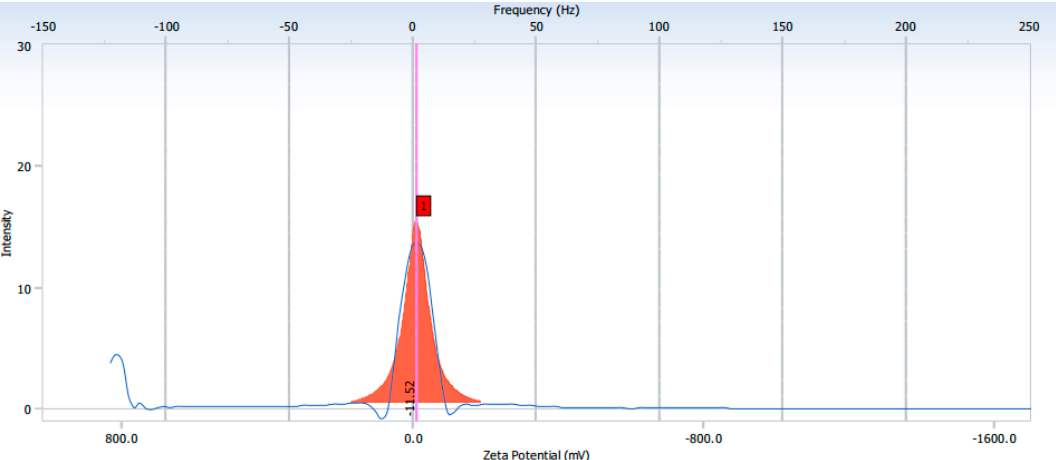
Figure 3. The zeta potential value of synthesized AgNPs.